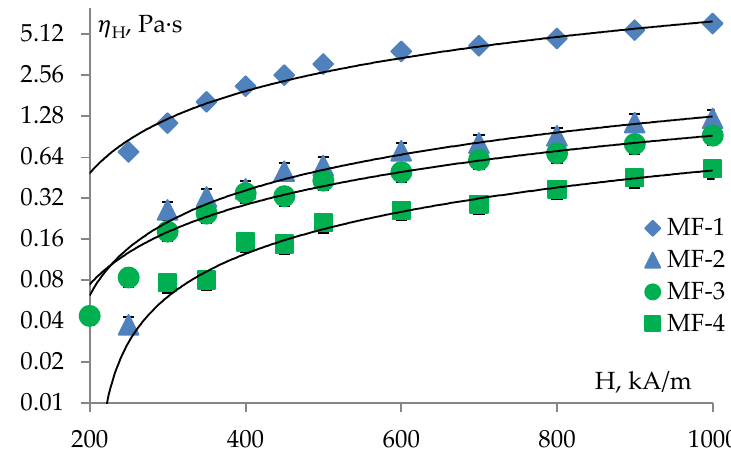
Figure 6. Dependences of viscosity for MF-1 – MF-4 samples.